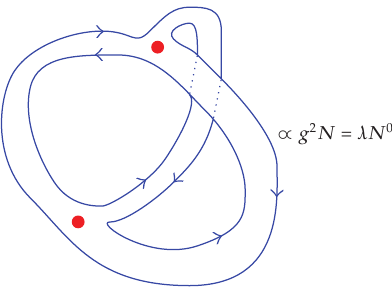
Figure 4: Non-planar (cid:2) but still oriented! (cid:3) graph that contributes to the vacuum → vacuum amplitude. Created by Wing-Ko Ho.